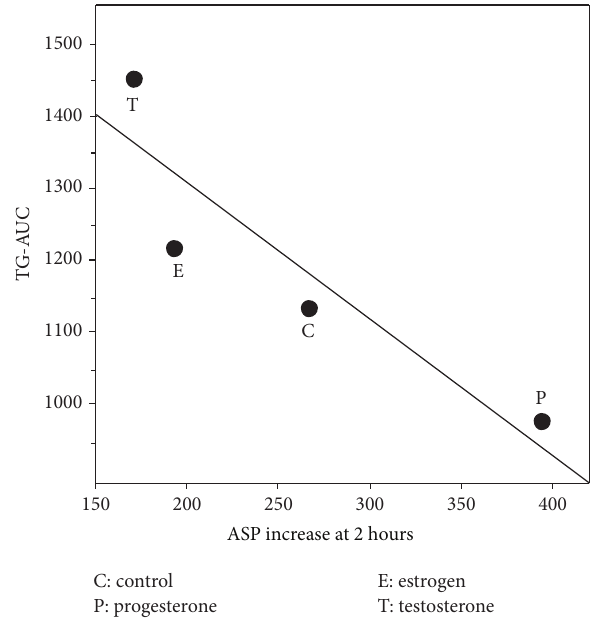
Figure 4: A simple scatter graph representing a negative association between mean postprandial ASP level increase at 2 hours and corresponding mean TG-AUC of the different hormone treated